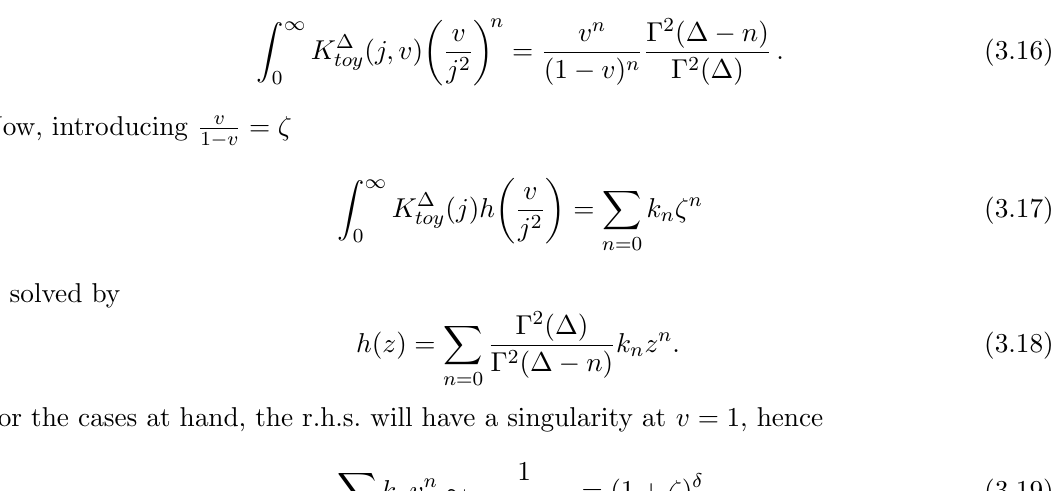
Figure 1 . Asymptotic behaviour of the coe(cid:14)cients c k for d = 3, (cid:1) = 0 : 518151 and (cid:1) (cid:15) = 1 : 41264. The data is consistent with the behaviour j c k +1 For instance, for spin s = 4, we have j 2 (cid:24) 12 and the error is of the order of c is extremely